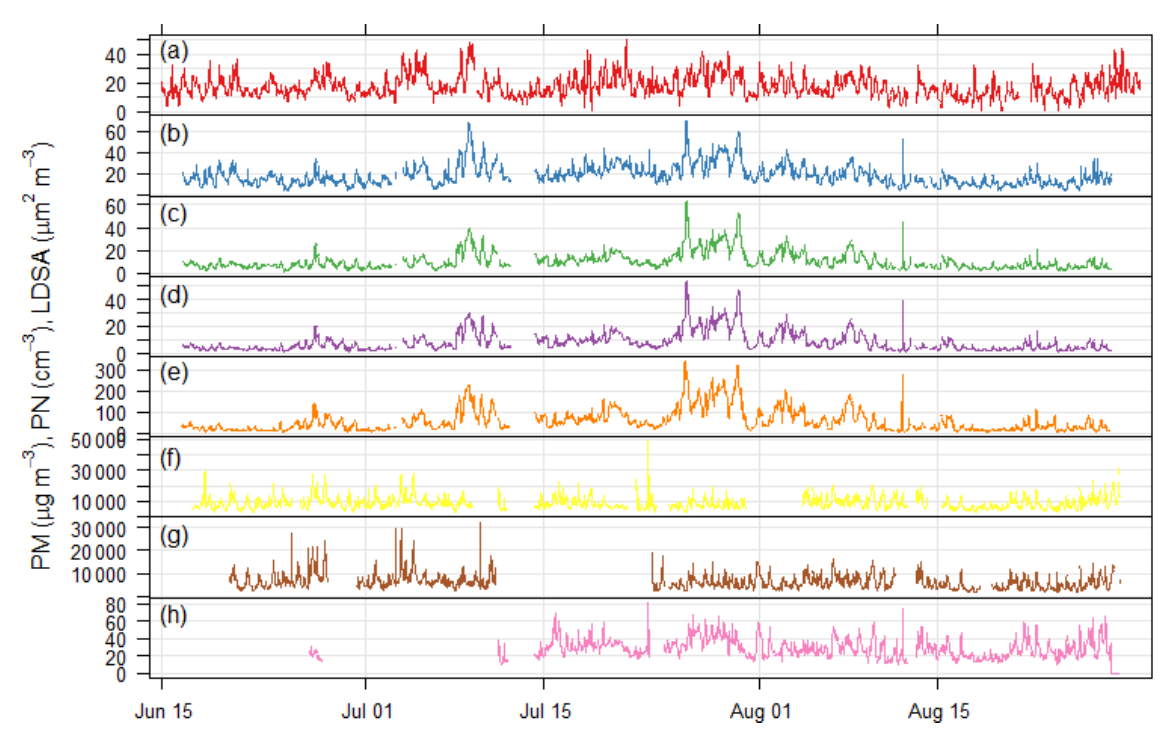
Figure 3. Time series of particulate matter mass, particle number, and lung depositable surface area concentrations measured at the Neukölln station during the BAERLIN2014 campaign. (a) BLUME PM 10 , (b) Grimm 1.108 PM 10 , (c) Grimm 1.108 PM 2 . 5 , (d) Grimm 1.108 PM 1